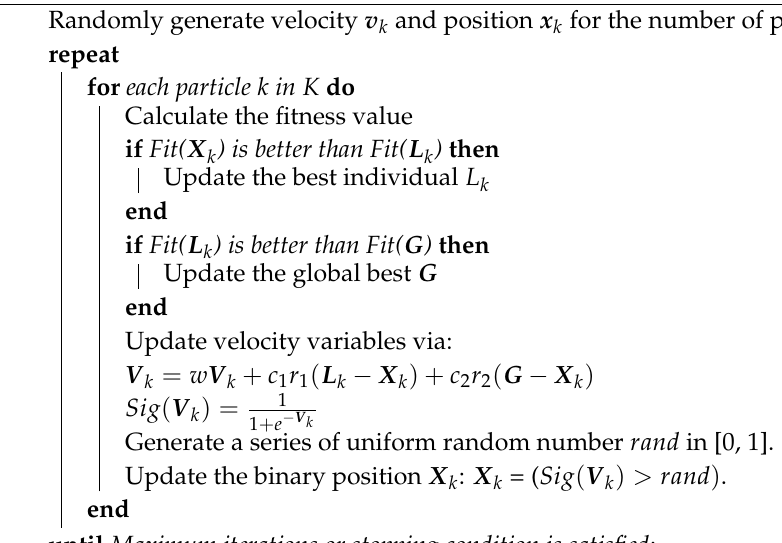
Algorithm 1: The standard binary particle swarm optimization (BPSO) algorithm.